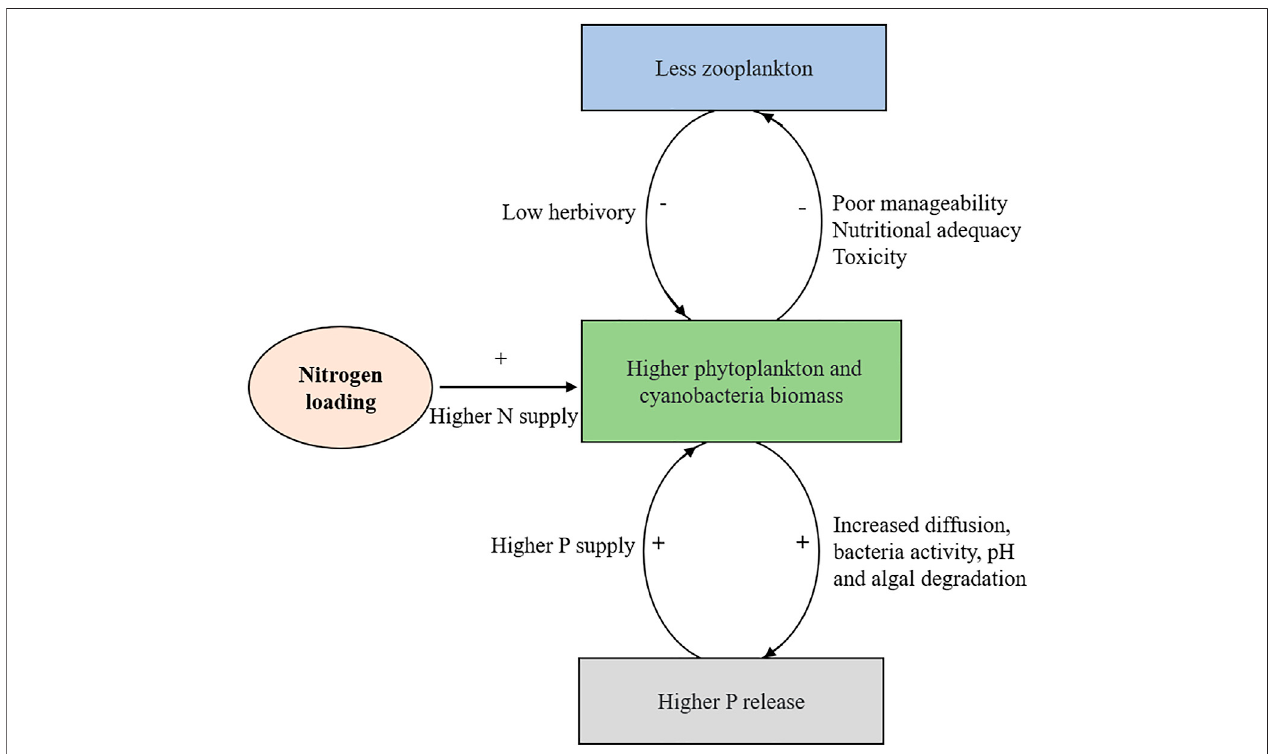
FIGURE 1 | Conceptual model of two feedback loops showing how nitrogen (N) loading boosts summer eutrophication in shallow lakes. Firstly, the addition of N mitigates N de fi ciency in summer, which increases algal biomass and subsequently causes higher P release from sediments via a series of mechanisms such as increased diffusion and pH. In turn, the new P, together with external N loading, snowballs the phytoplankton biomass and thereby creates a positive feedback. Secondly,Nadditionmayalsoincreasethedominanceoftoxic, fi lamentous,orcolonialcyanobacteriaineutrophiclakes,whichexpectedlyreducestheef fi ciencyof zooplankton herbivory due to poor manageability and nutrition value and high toxicity. Also, the decline in grazing control favors phytoplankton growth.